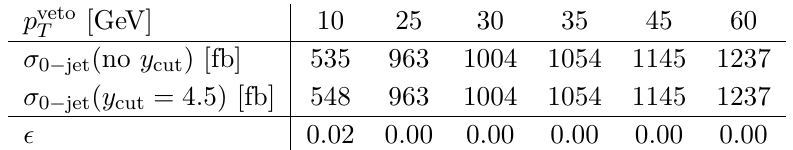
Table 6 . The pp → W − W + → 2 ‘ 2 ν + 0-jet cross-section at NNLO , with and without a jet rapidity